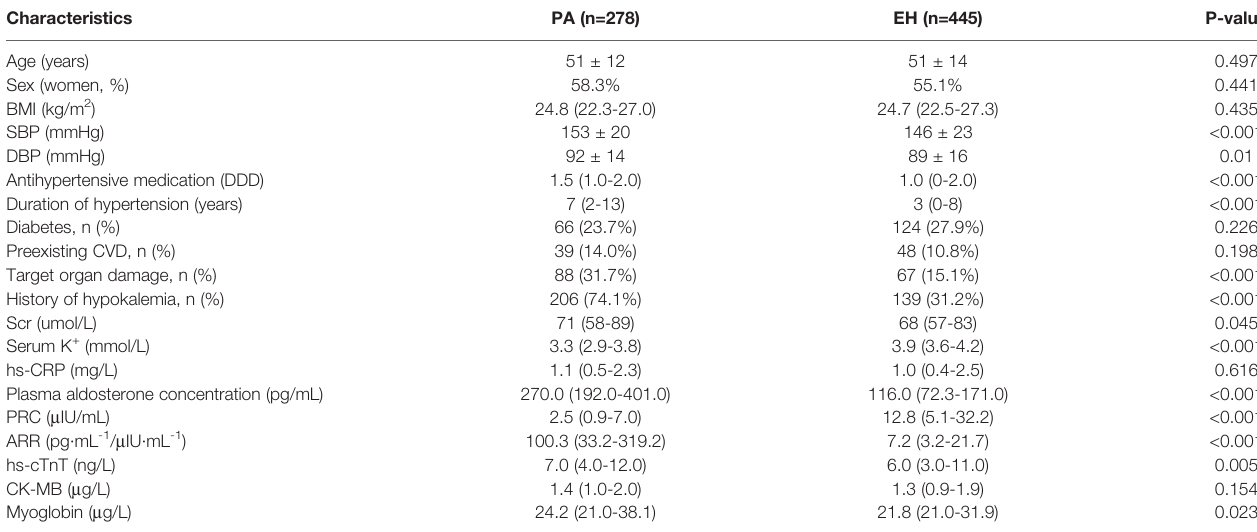
TABLE 1 | Demographic and clinical characteristics of the patient cohorts.